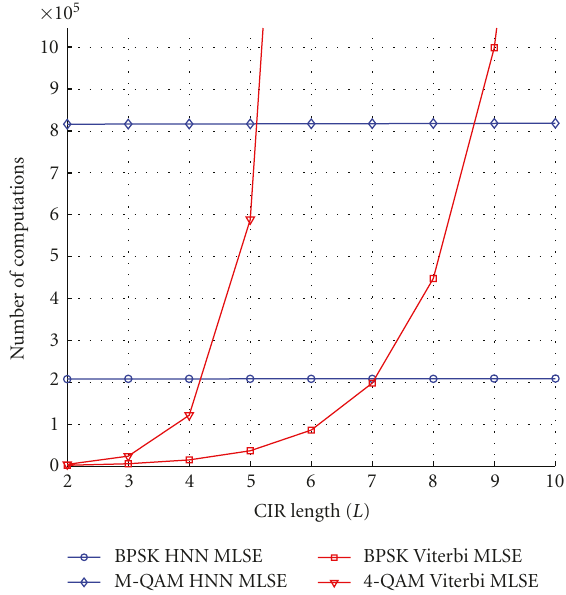
Figure 10: Computational complexity comparison between the HNN MLSE and Viterib MLSE